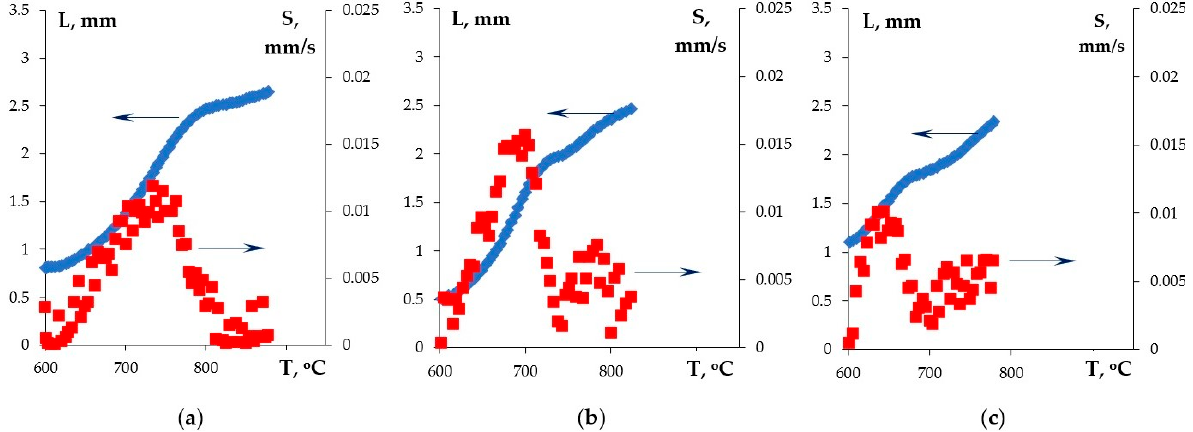
Figure 9. Temperature curves of shrinkage value L (blue) and shrinkage rate S (red) for Na 1.2 Zr 1.9 Co 0.1 (PO 4 ) 3 ( a ), Na 1.5 Zr 1.75 Co 0.25 (PO 4 ) 3 ( b ), and Na 2 Zr 1.5 Co 0.5 (PO 4 ) 3 ( c ) phosphates.